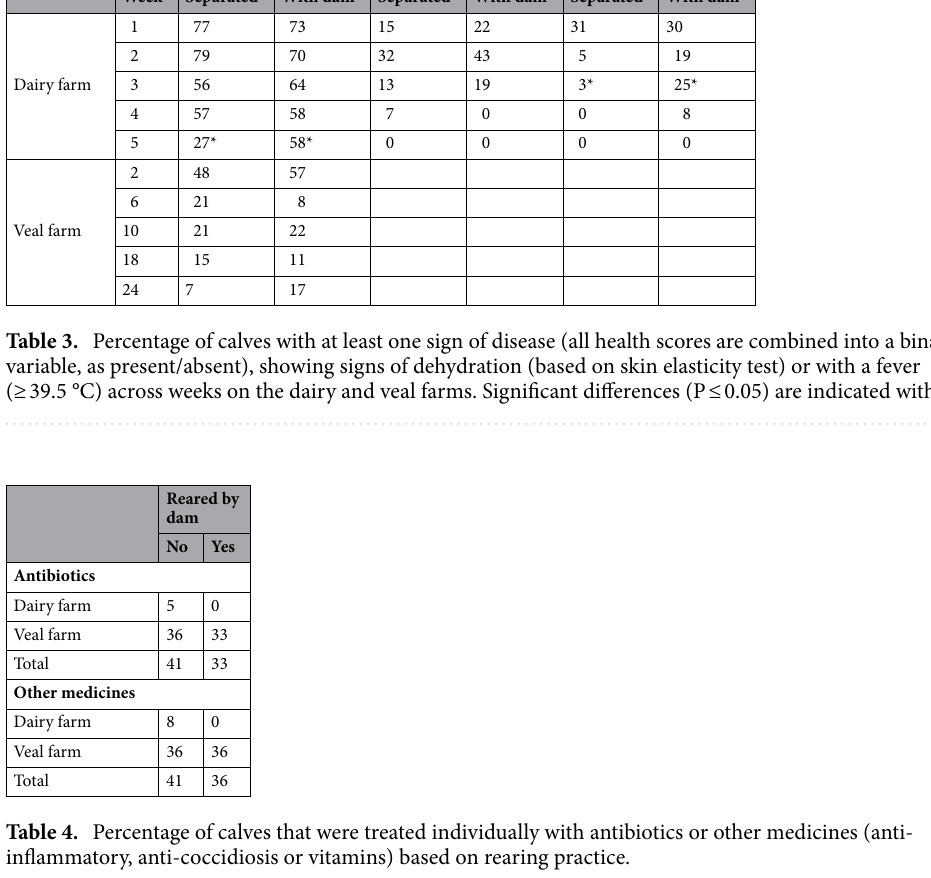
The statistical output, as well as means and SEM for all haematological param- eters across rearing treatment and sampling time is presented in Table 5. Regarding the other factors, males of the meat breeds had higher monocyte (P < 0.001) and basophil (P = 0.014) percentages than males of the dairy breeds. Within the meat breed, males had higher basophil percentage than females (P = 0.014). Calves from dams in parities 1–2 had higher counts (P = 0.002) and percentages (P = 0.008) of eosinophils than calves from dams in parities 3–4 and 5–8. Calves born with assistance had lower RBC (P = 0.049), Hb (P = 0.037) and Ht (P = 0.027) than calves born without assistance.